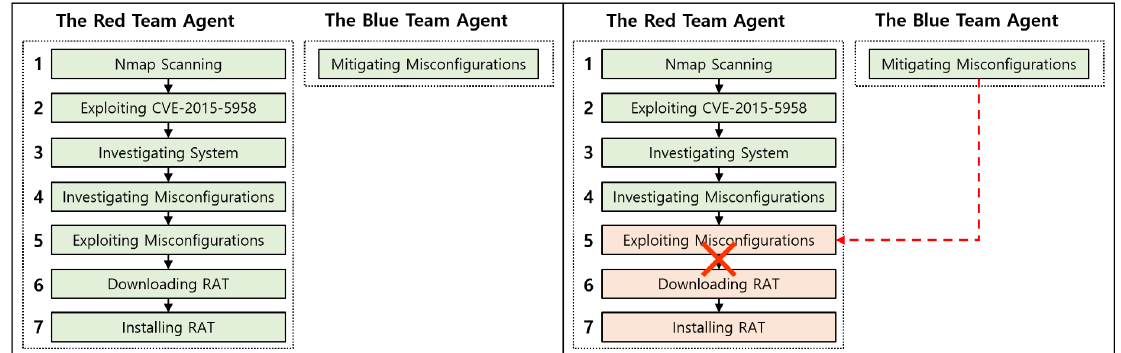
Figure 16. Available techniques for the red team agent and the blue team agent on the system with CVE-2015-5958 and misconfiguration of sudoers (left) and the red team agent’s failure of exploiting the misconfiguration by the blue team agent’s mitigation (right).